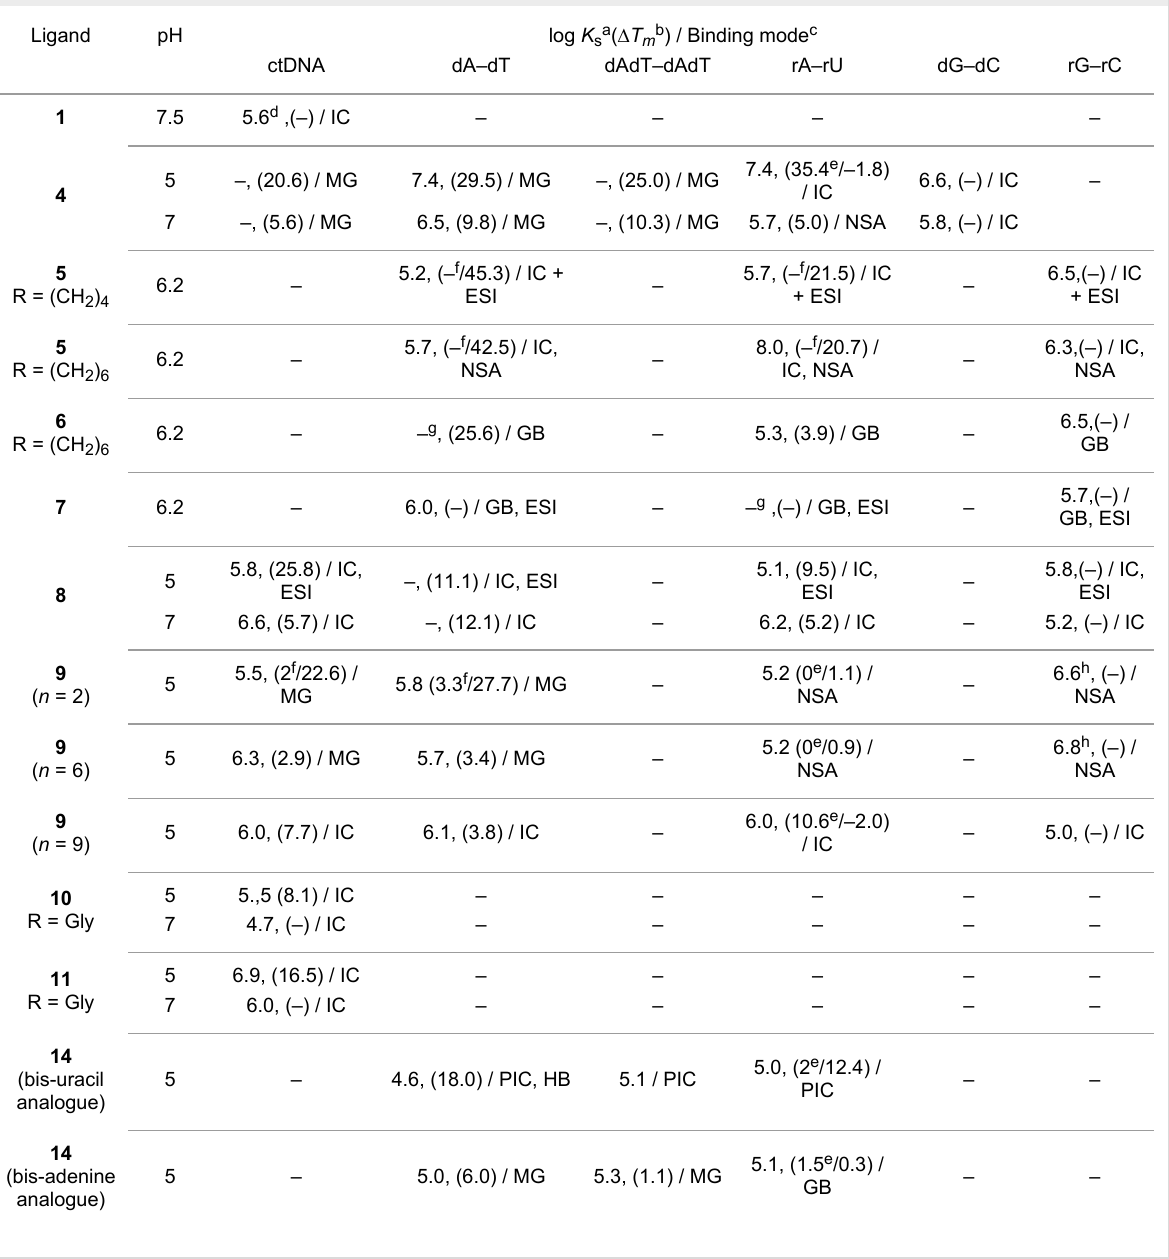
Table 1: Binding affinities (log Ks ); thermal denaturation effects and proposed binding modes of chosen phenanthridine and phenanthridinium deriva- tives with natural and synthetic polynucleotides: ds-DNA and ds-RNA.